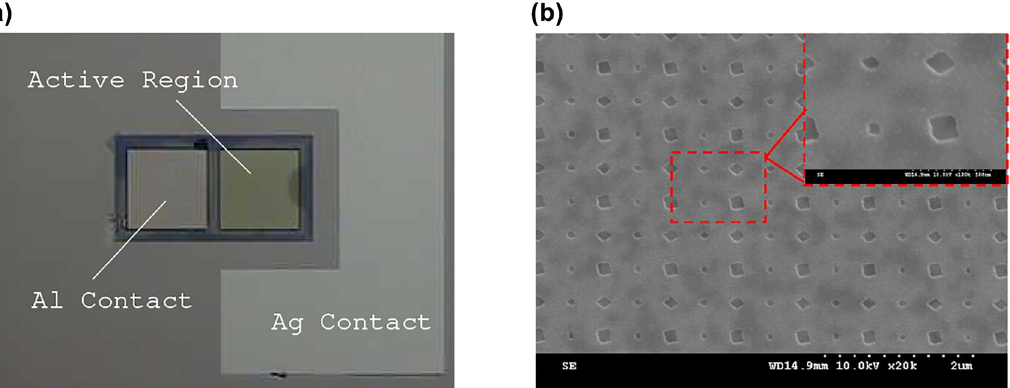
Figure 8: The fabricated photonic-plasmonic Schottky PD: (a) the optical image (at 500 × ), showing the layout of top-Al and bottom-Ag electrodes along with the active region having an area of ∼ 4 . 6457 × 10 − 2 mm 2 and (b) the scanning electron microscope image of the fabricated array of nano-square prisms. The optical image was taken after the deposition of Si